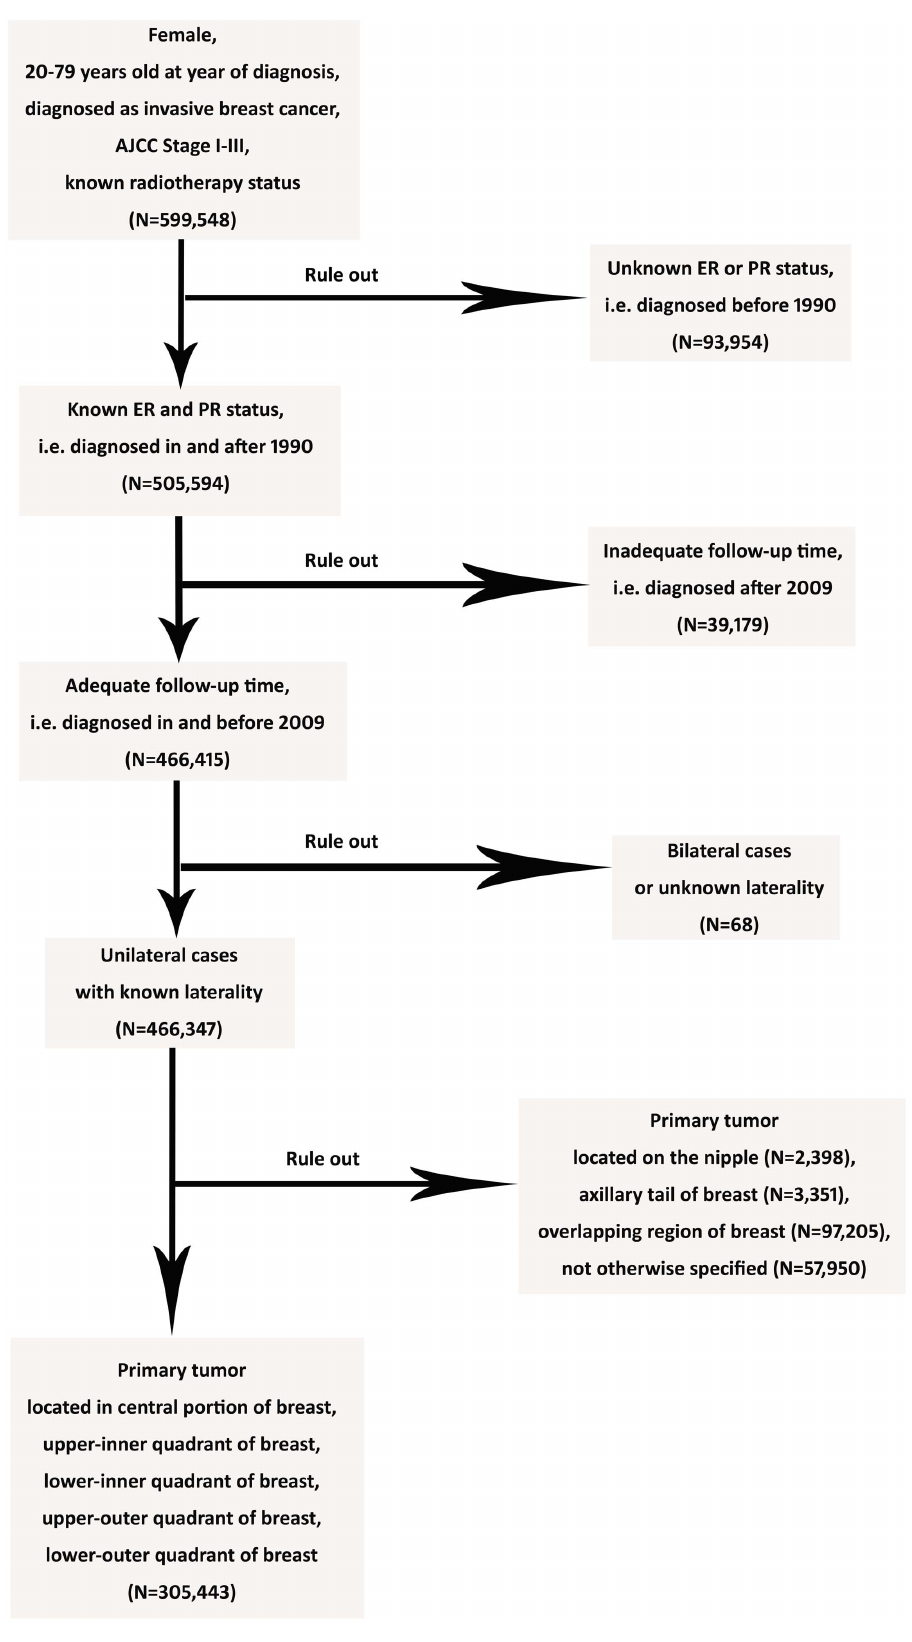
Figure 2. Flow Diagram of Inclusion Criteria and Exclusion Criteria. The inclusion criteria are presented as follows: female sex, between 20– 79 years at age of diagnosis, diagnosed as invasive breast cancer between 1990 and 2009, AJCC stages I to III and known radiotherapy status (599,548